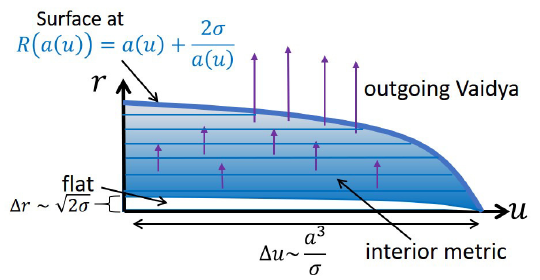
Figure 9. Time evolution of the evaporating black